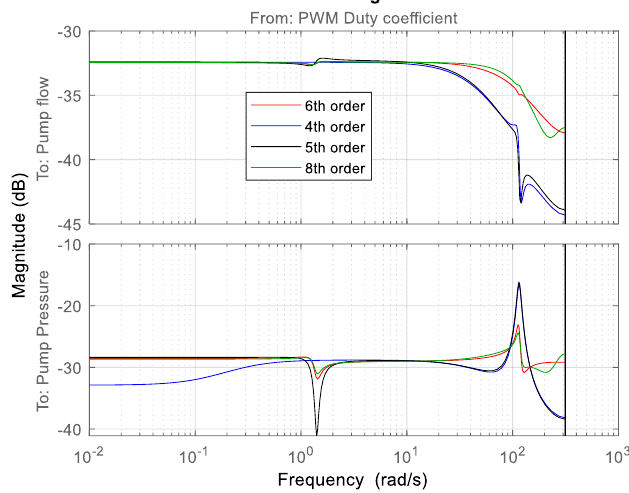
Figure 11. Comparison of frequency responses of 4th, 5th, 6th and 8th order model in case of non-loading.